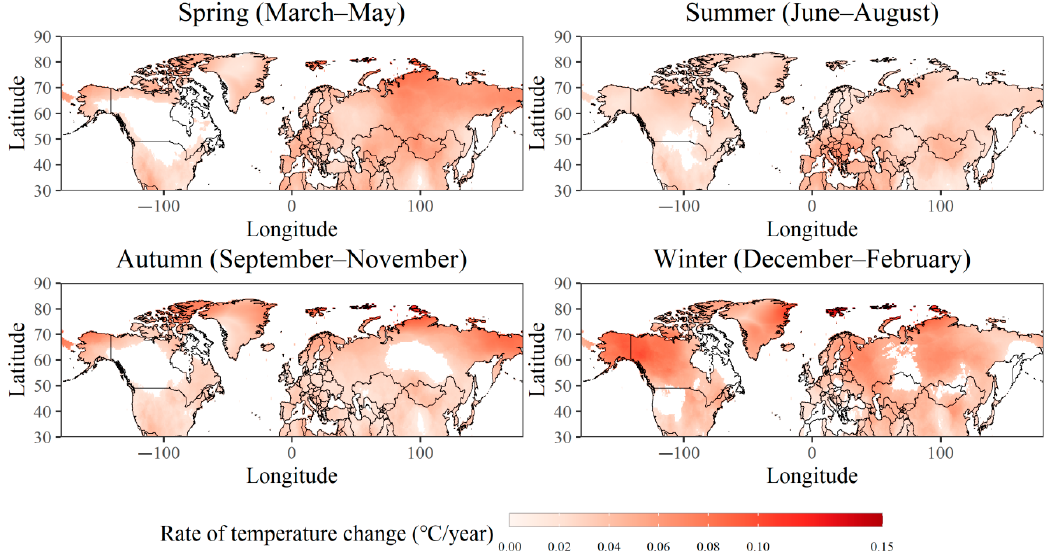
Figure 6. Spatial distributions of seasonal temperature trends over the NH, from 1967 to 2018, based on CRU TS 4.0. Only the significant ( p < 0.1 ) trends are shown.